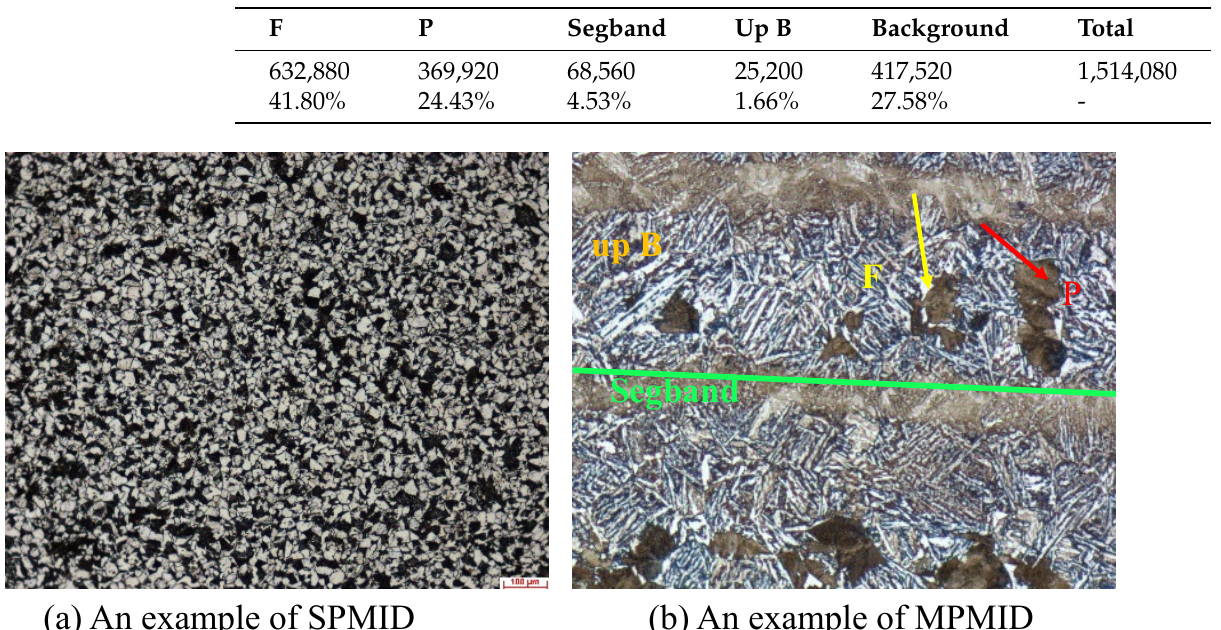
Figure 6. The examples of our built datasets. ( a ) SPMID ( b )